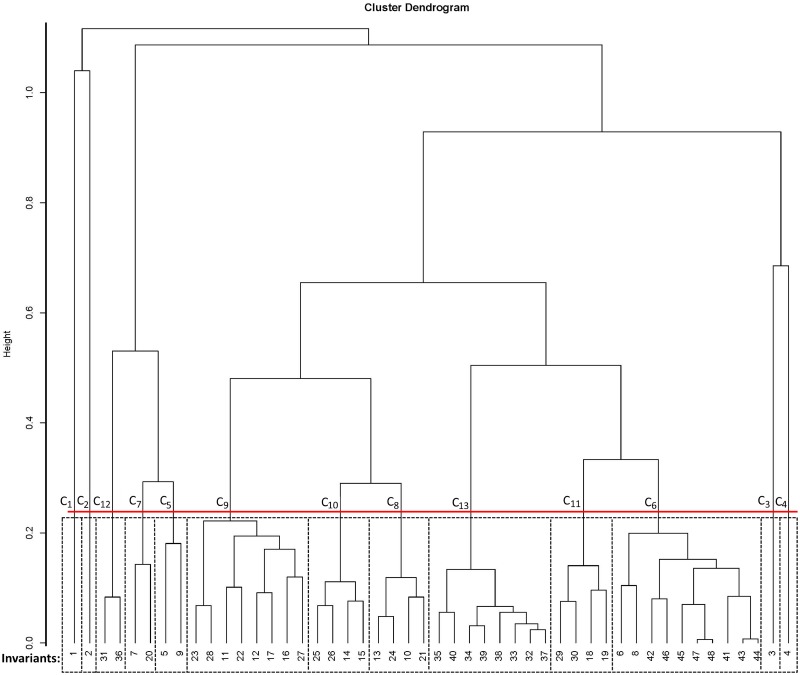
Cluster dendrogram.